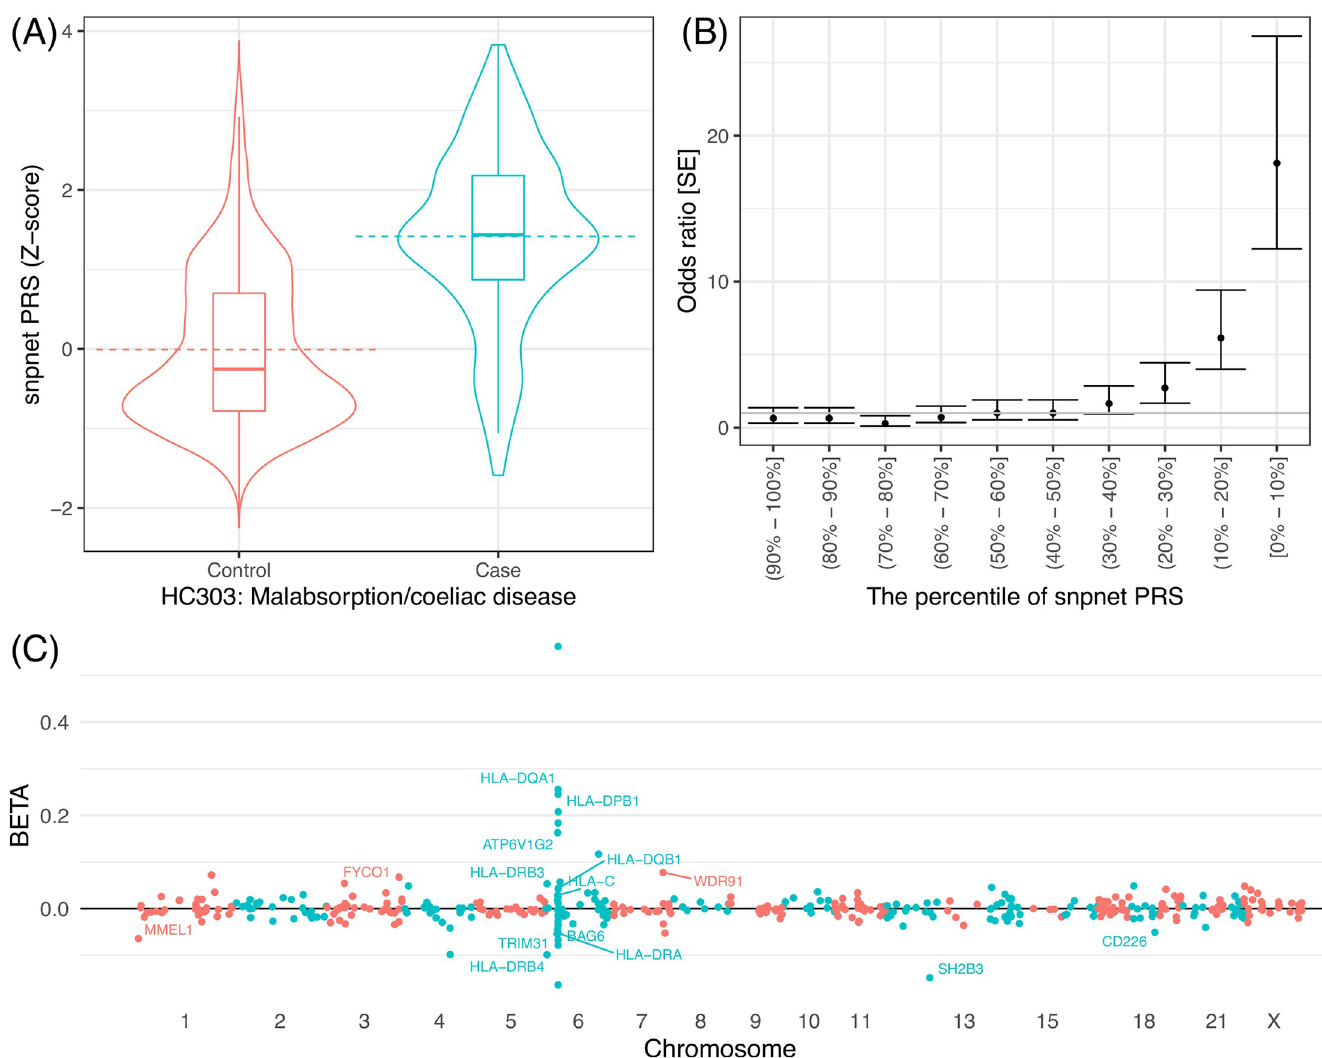
Fig 4. The sparse PRS model and their predictive performance for celiac disease. (A, B) the predictive performance of celiac disease PRS. (A) the celiac disease PRS distribution (y-axis) in a hold-out test set stratified by the disease case status (x-axis). The dashed lines represent the mean and the quantiles are shown as box plots. (B) The disease prevalence odds ratio compared to the individuals with middle (40–60 th percentile) PRS score stratified by PRS percentile bins. The error bars represent standard error (SE). (C) the coefficients of the celiac disease PRS model. The estimated effect size (y-axis) for each genetic variant (x-axis) is shown. The gene symbols are annotated in the plot for coding variants and HLA allelotypes with large effect size estimates.